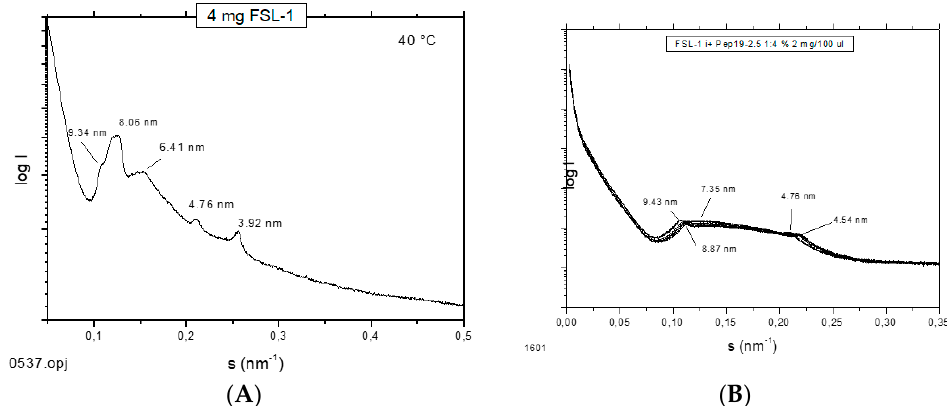
Figure 12. Small-angle X-ray scattering patterns at 40 °C for FSL-1 in the absence ( A ) and presence ( B ) of Pep19-2.5. The logarithm of the scattering intensity log I is plotted versus the scattering vector s (=1/d, d = spacings of the reflections).